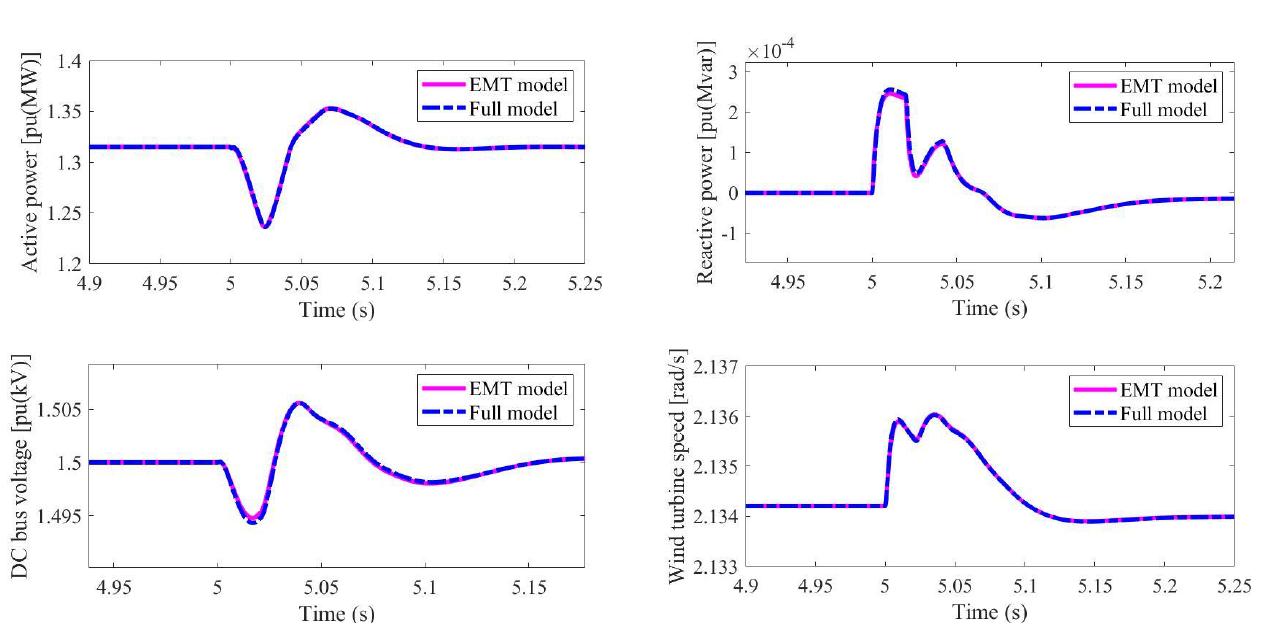
Figure 2. Grid voltage disturbance: full model vs. EMT model.